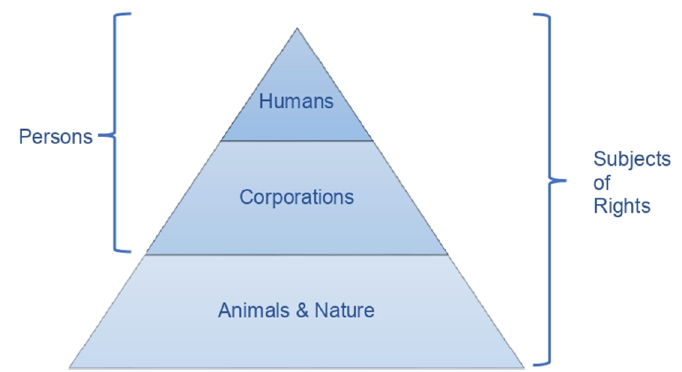
Figure 1. The Subset View.